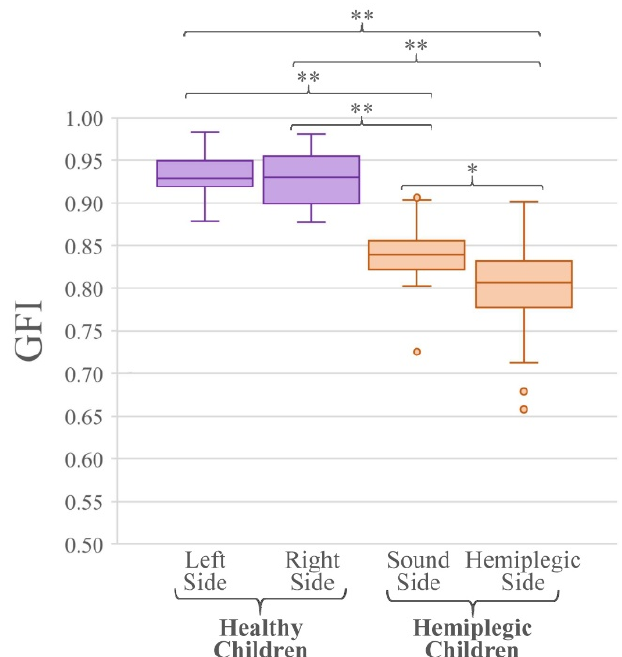
Figure 8. Boxplots of the GFI values of healthy and hemiplegic children of the test set. Asterisks highlight statistically significant differences between groups or sides (*: p < 0.05 and **: p < 0.001). Circles represent outliers.